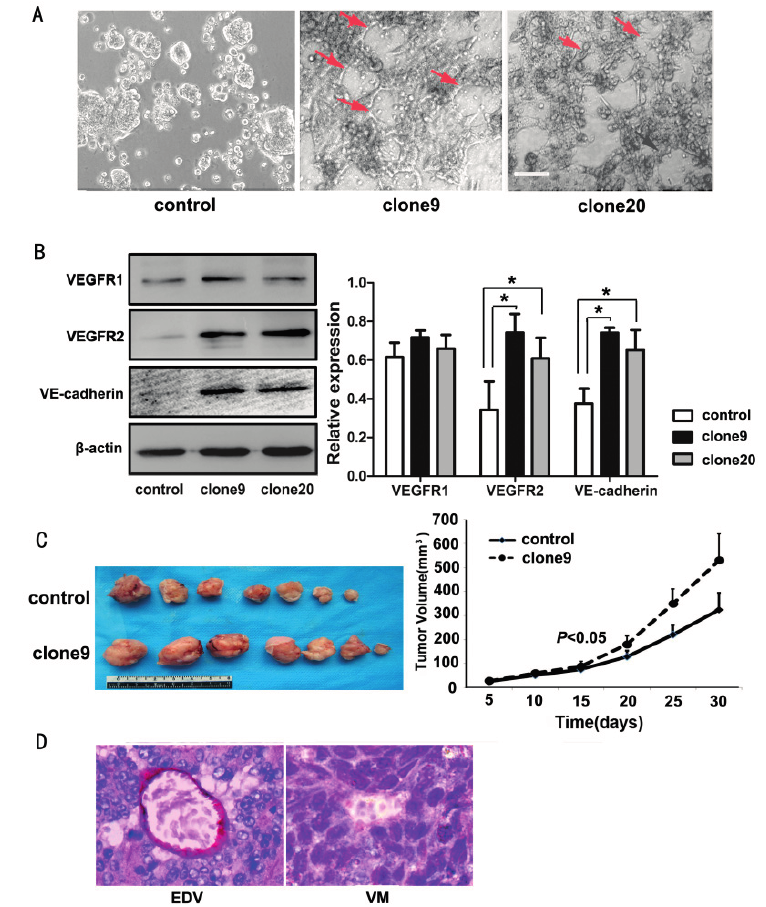
Figure 4. Wnt3a promoted the VM-forming ability in HT29 cells. ( A ) HT29 cells cannot form typical tube-like structures in the 3D culture, whereas Wnt3a-overexpressing clone9 and clone20 cells formed few tubular structures (red arrows). Scale bar: 100 μ m; ( B ) Upregulated Wnt3a expression in HT29 cells results in increased VEGFR2 and VE-cadherin expressions. No significant change in VEGFR1 expression was observed ( left ) ( * p < 0.05). Relative amount of protein expression of VEGFR1, VEGFR2, and VE-cadherin compared with β -actin ( right ); ( C ) Representative xenograft tumors of the control or Wnt3a-overexpressing HT29 cells (clone9) on the 30th day post injection ( left ). Tumor volumes are monitored over time ( right ); ( D ) VM structure and endothelial-dependent vessels in xenograft tumors (CD34/PAS double staining,